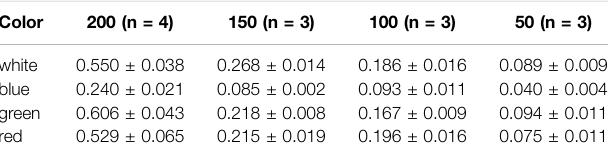
TABLE 3 | Maximum growth rates µ max d − 1 of Picochlorum sp . at color illumination of 200 – 50 μ mol m − 2 s − 1